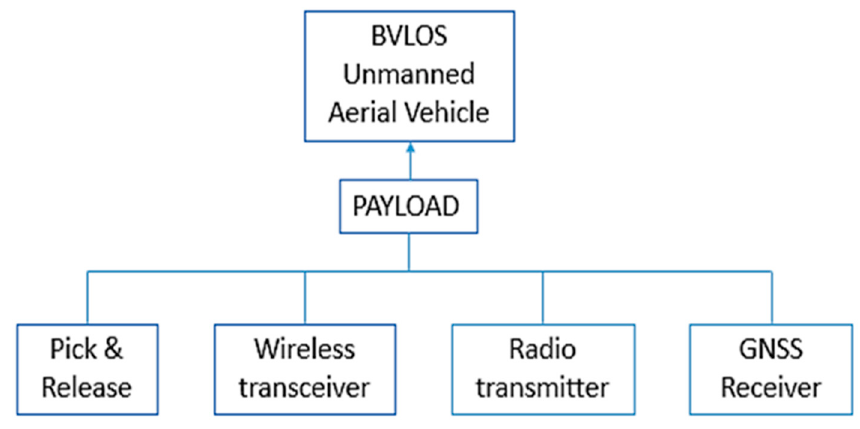
Figure 5. Full featured drone payload block diagram representing the main devices inside.